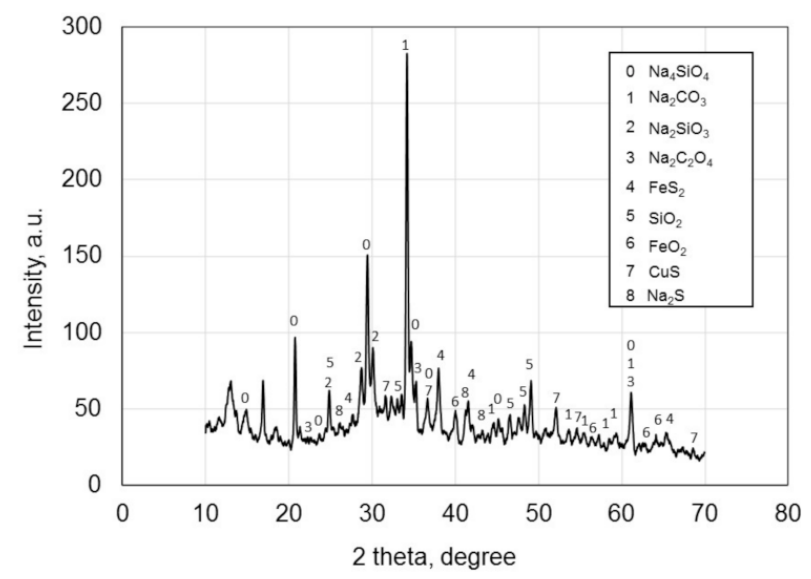
Figure 8. X-ray pattern for the slag obtained for an initial charge of 40 wt.% of Na 2 CO 3 and 0.4 g of SiC to 1000 ◦